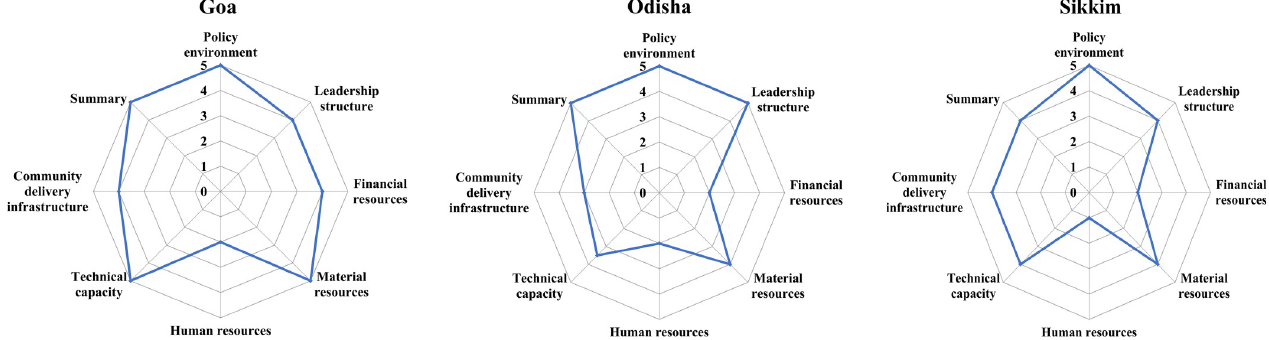
Fig 1. Median Readiness by health system